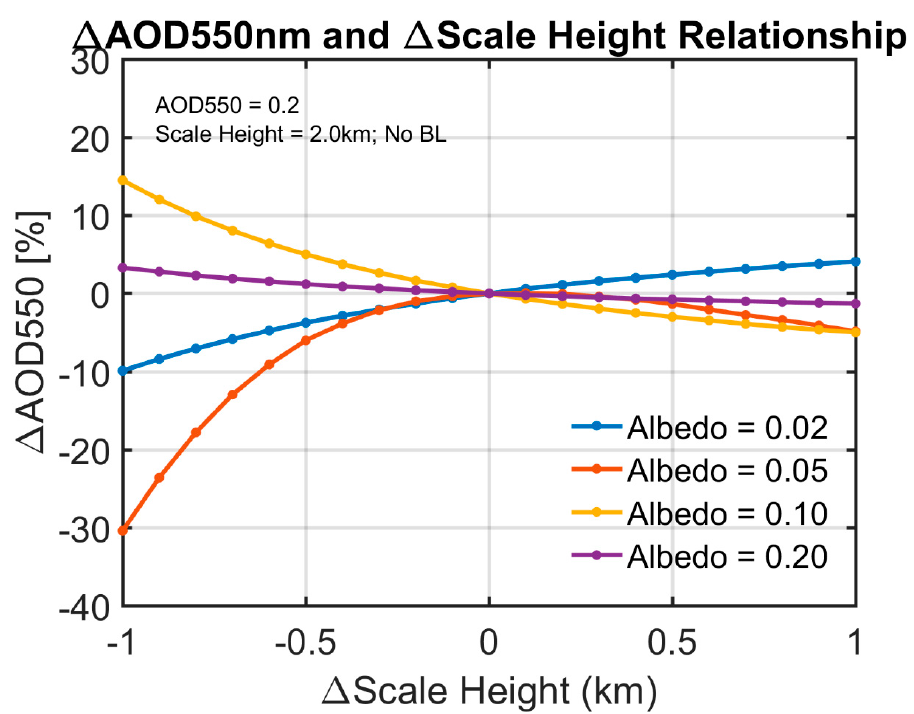
Figure 4. The relative errors of AOD 550 nm with the errors of scale height under four surface albedos (0.02, 0.05, 0.1, 0.2). The fine absorbing aerosol model is used in this experiment.